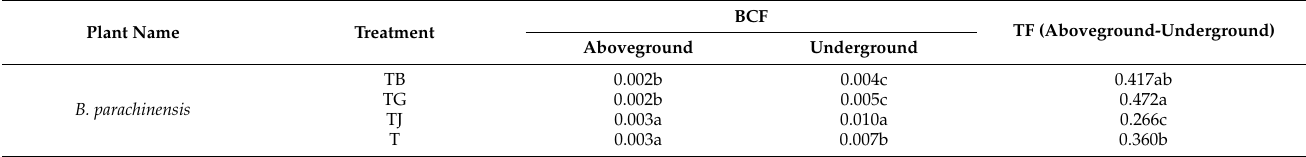
Table 5. TF and BCF of Cr in B. parachinensis under different treatments.